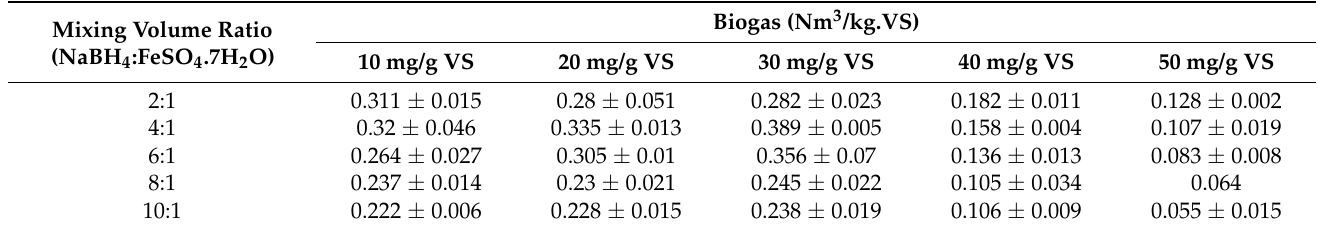
Table 4. Biogas yield of all BMP tests of substrates mixture of OMWW:CM with different doses of NP-ZVI and various MVR (biogas yield of the control test was 0.216 Nm 3 /kg